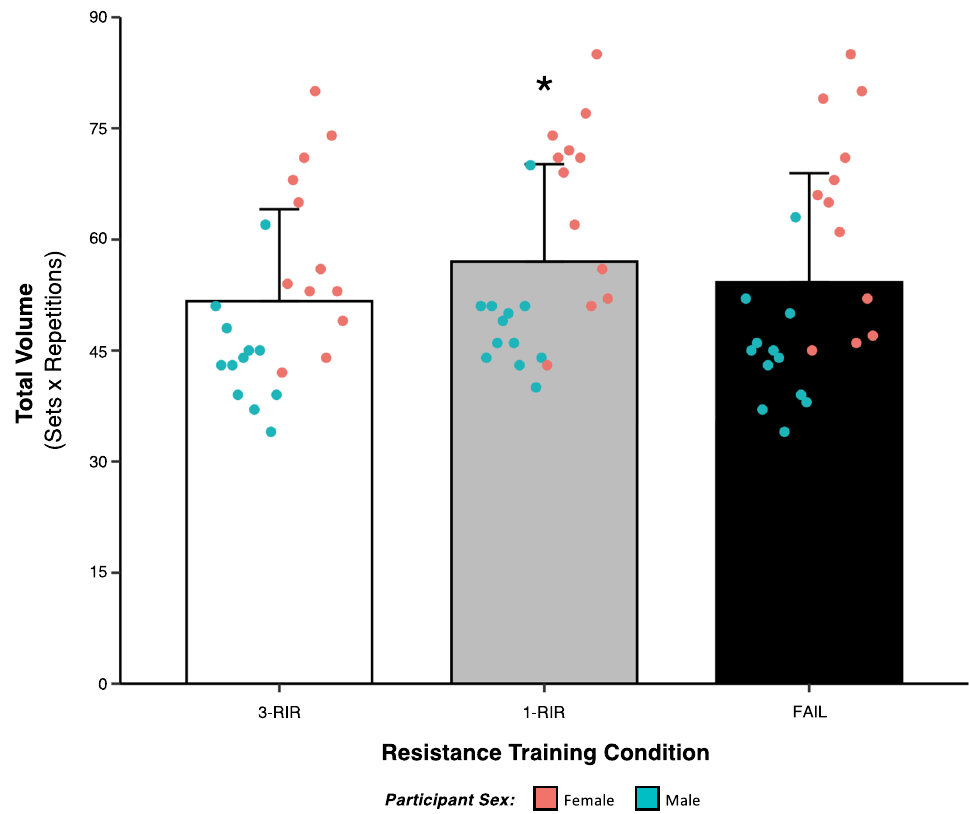
Fig. 2 Influence of proximity-to-failure on total volume completed. Total volume calculated as the number of repetitions performed across six sets for each protocol (sets repetitions). Data shown are presented as both protocol means ( × significant difference from FAIL and 3-RIR